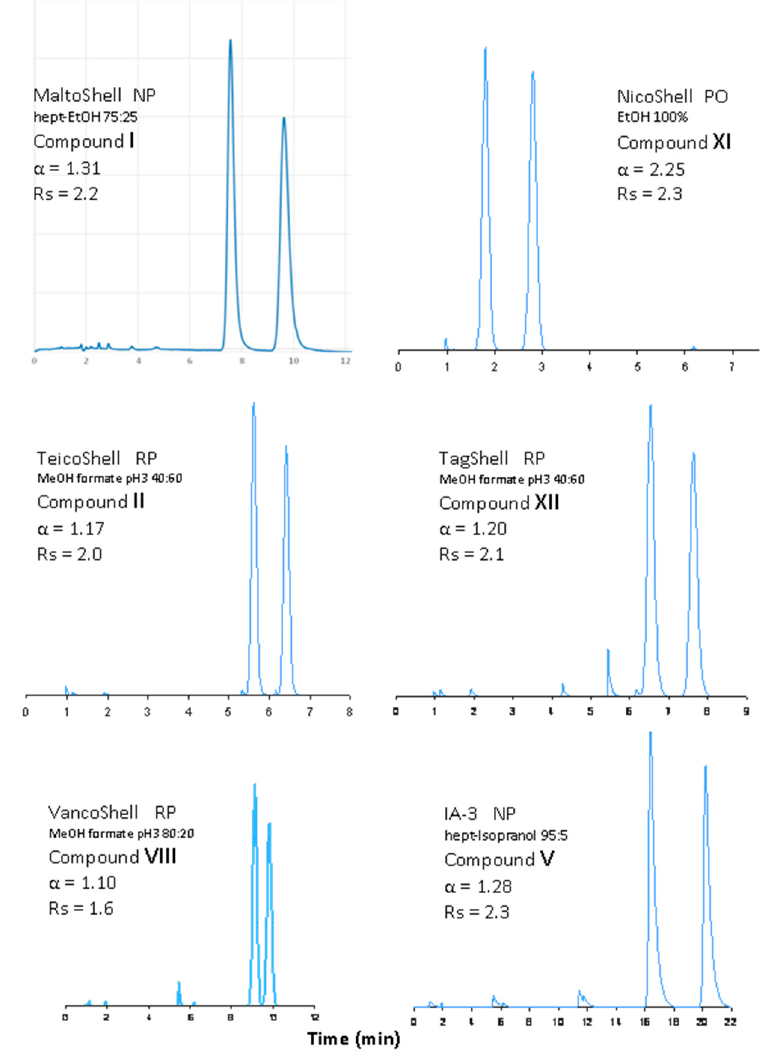
Figure 3. Examples of separation of the enantiomers of the Figure 1 chiral azoles on each of the Table 1 chiral columns. Mobile phase flow rate: 1 mL/min, 30 ◦ C, detection UV 254